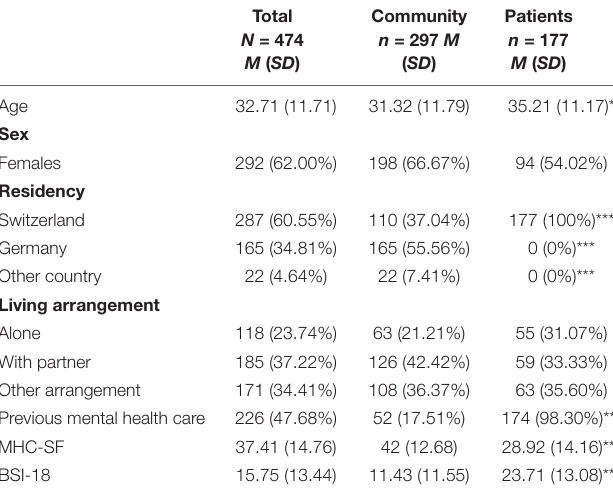
TABLE 1 | Sample characteristics of community and clinical